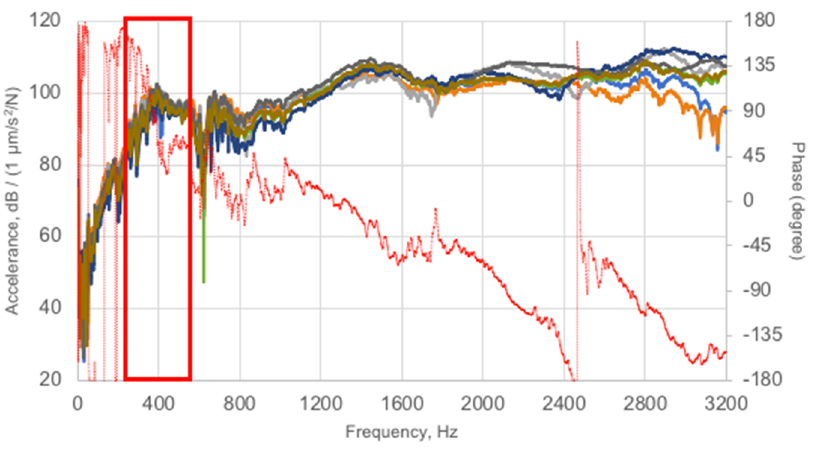
Figure 7. Frequency response functions of the test gearbox.